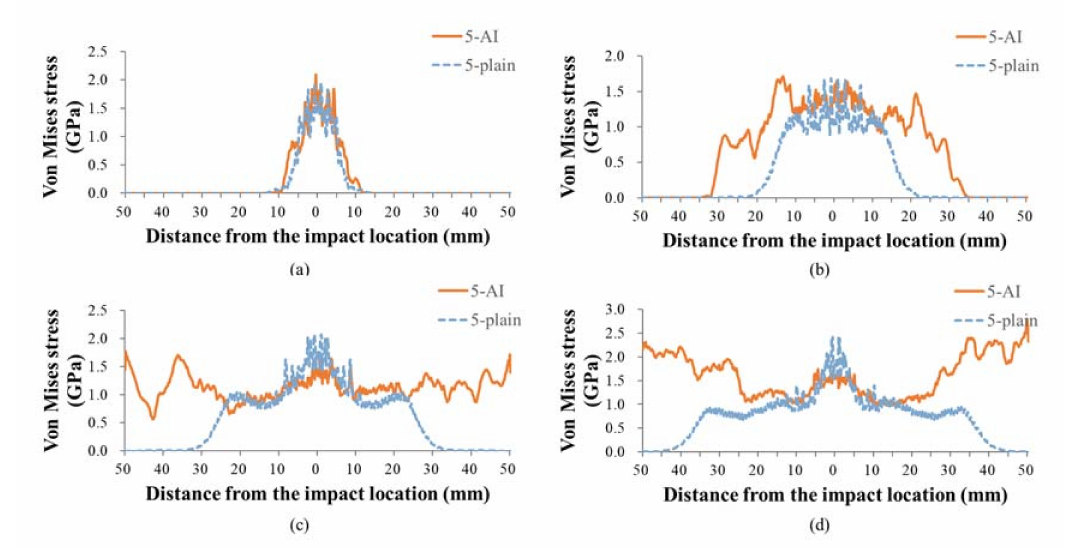
Figure 12. The stress distribution in 5th weft yarns at ( a ) 3 µ s; ( b ) 6 µ s; ( c ) 9 µ s; and ( d )12 µ s in 5-AI and 5-plain